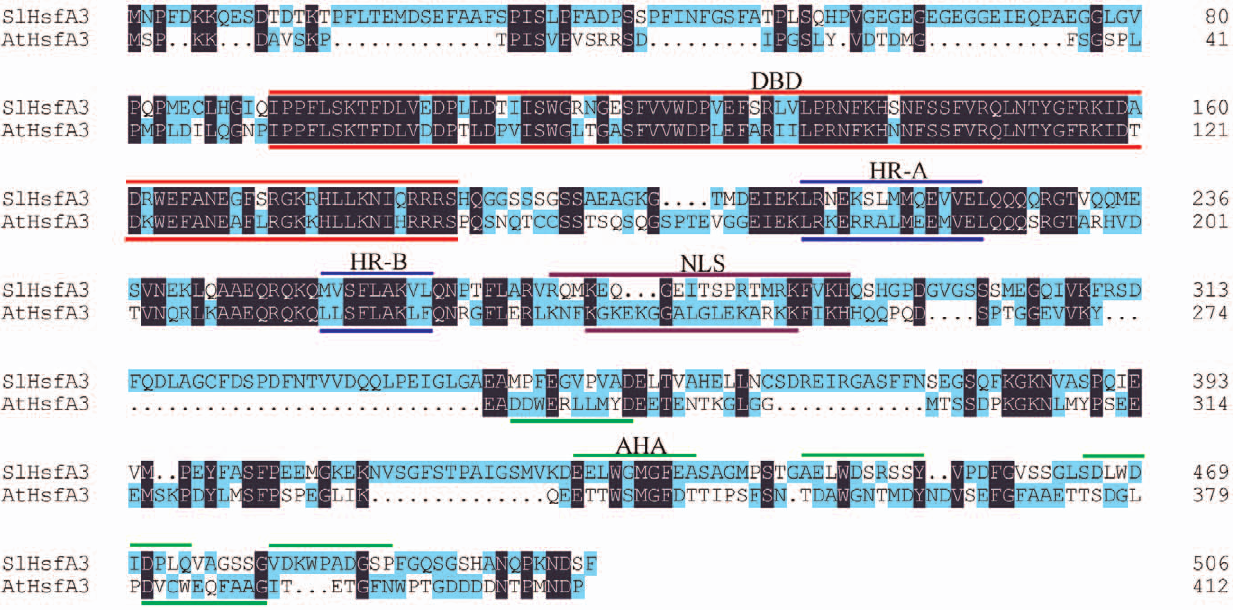
Figure 1. Alignment of HsfA3 proteins from tomato ( Solanumlycopersicum ; Sl ) and Arabidopsis ( Arabidopsisthaliana ; At ) . The sequence alignment was performed using ClustalX 2.0 and DNAMAN software. Conserved amino acids in both proteins are highlighted in black and nonidentical residues are shaded in light blue. The dashes indicate gaps introduced for better alignment. The signature domains of both Hsfs are indicated by color bars: DNA-binding domain (DBD), red; heptad repeat pattern of hydrophobic amino acid residues (HR-A/B), dark blue; nuclear localization signal (NLS), purple; transcriptional activation domain (AHA), green.